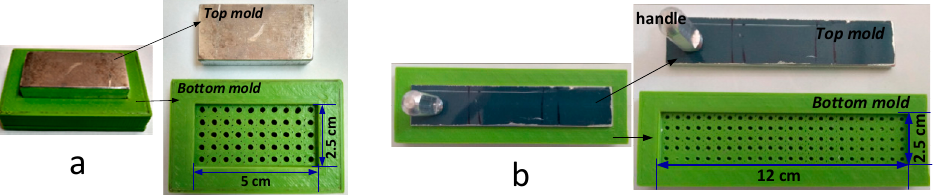
Figure 1. Molds for bio-composite sheet for testing the ( a ) tensile strength and ( b ) bending strength.